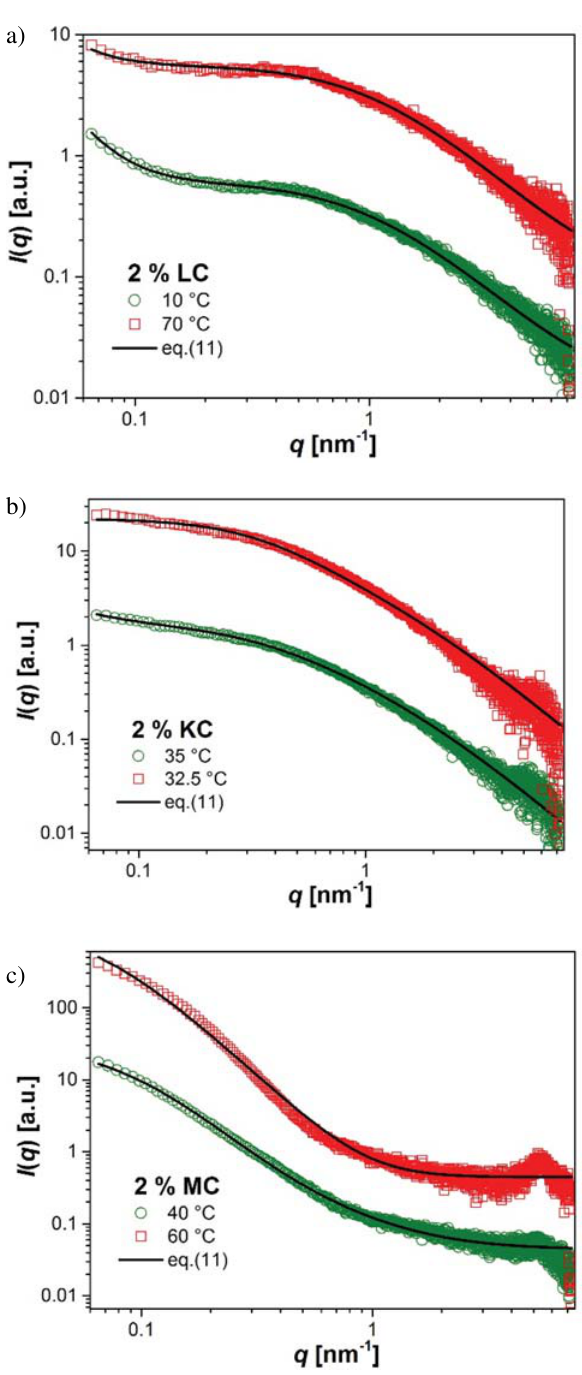
Figure 4 : The fits of Equations (10) to experimental scattering cur- ves of 2 wt. % (a) LC, (b) KC, and (c) MC at various temperatures. Curves have been shifted by a constant value for the sake of